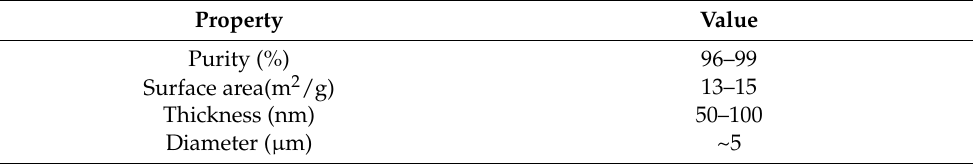
Table 3. Properties of graphene.